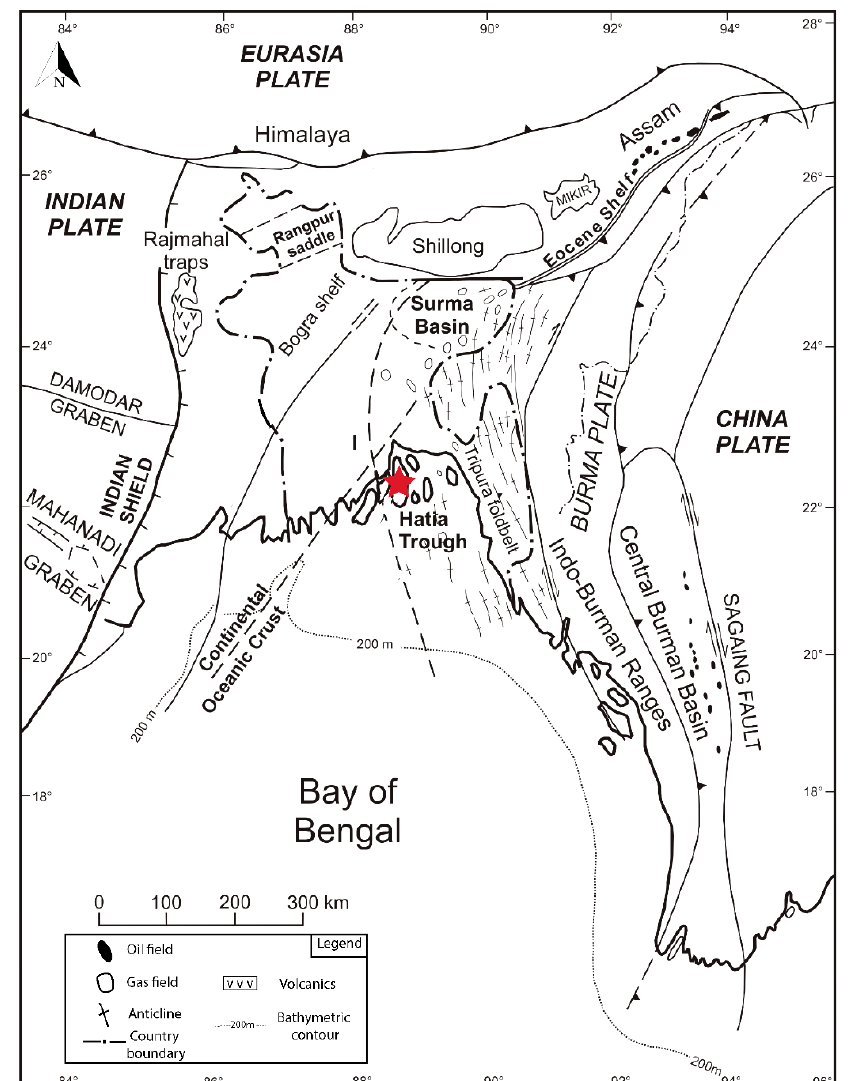
Figure 1. Regional map of the Bengal Basin showing major structural elements (after Curiale et al. 2002). Red asterisk shows the approximate location of the Shahbazpur structure within the Bengal Basin.